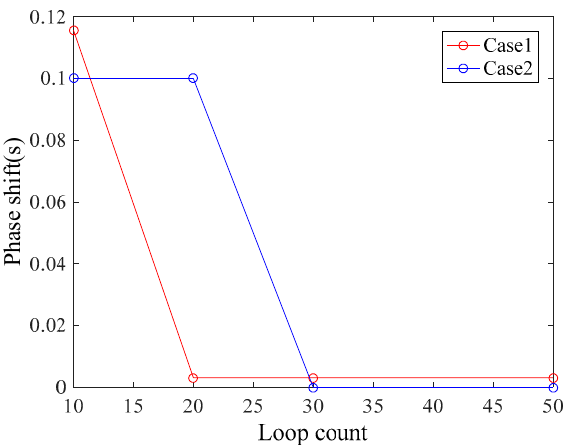
Figure 7. Sensitivity analysis of the number of loops used in the realignment algorithm. Case 1 is the case wave0712 with 7 cm wave height and 1.2 s wave period, and case 2 is the case wave0512 with 5 cm wave height and 1.2 s wave period.